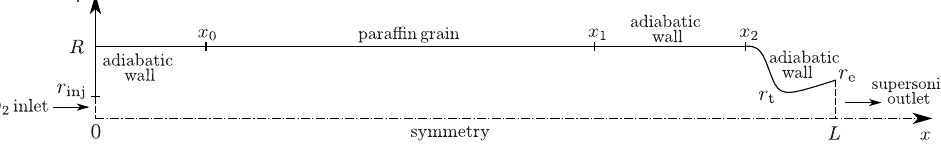
Figure 1. Computational setup used for the axisymmetric numerical